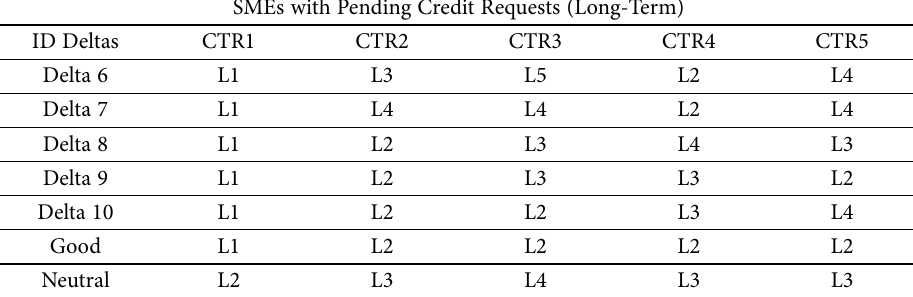
Table 6. SMEs pending credit requests